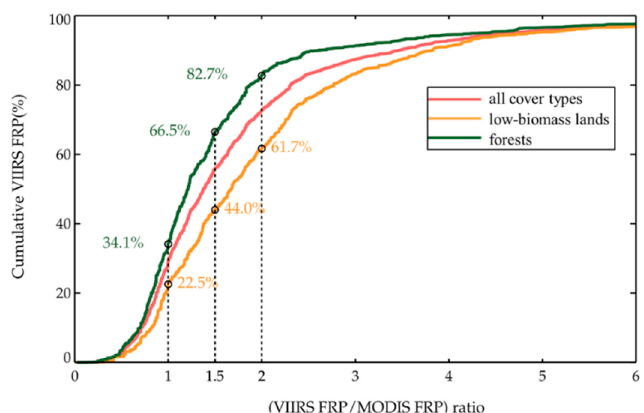
Figure 8. Cumulative sum of VIIRS FRP (%), expressed as function of the per-grid cell VIIRS-to-MODIS FRP ratio.